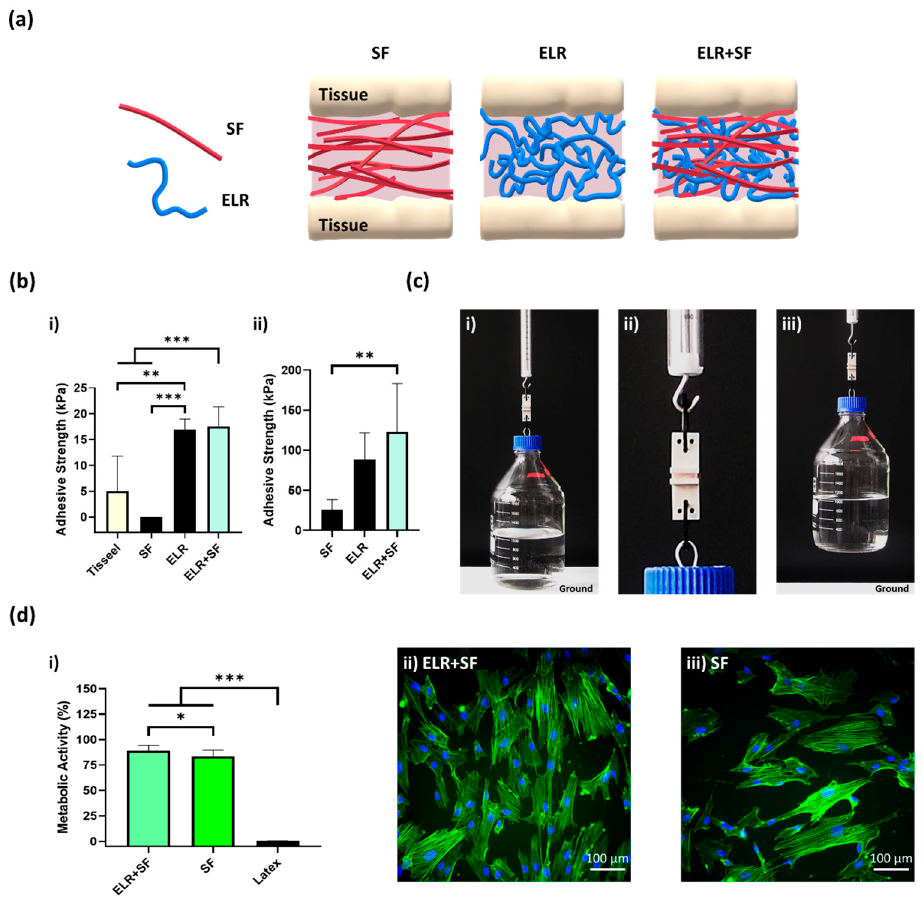
Figure 6. ( a ) Schematic representation of a composite bioadhesive based on SF and ELR. ( b ) The adhesive strength of the composite bioadhesive (10% ELR + 10% SF) on ( bi ) porcine skin and ( bii ) bone tissue. ( c ) Lifting of a glass bottle containing 1 L of water (overall weight 2 kg) with 10% ELR + 10% SF with 2.5 cm 2 of porcine bone. ( ci ) Image just before lifting, ( cii ) close-up image of the bone surfaces glued with the bioadhesive 10% ELR + 10% SF, and ( ciii ) 2-kg-weight bottle suspended in the air. ( di ) Metabolic activity of SMCs incubated with the extracted media of the adhesives (* p < 0.05, ** p < 0.01, *** p < 0.001). Morphological images of SMCs under a fluorescence microscope after incu- bation with extracted media from ( dii ) ELR + SF and ( diii ) SF. The actin filaments of the cytoskeleton and nuclei are labeled with phalloidin-488 (green) and DAPI (blue),